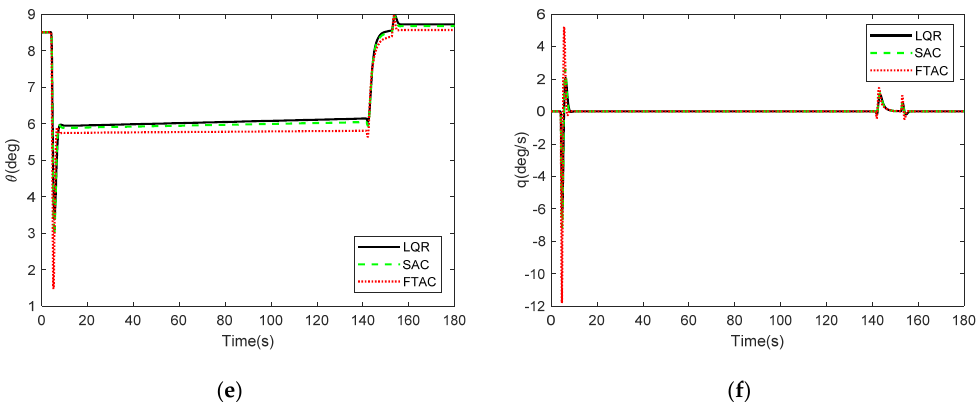
Figure 8. Scenario 1–No wind disturbance, ( a ) Altitude response ( b ) Altitude error. ( c ) Velocity response ( d ) Descent rate response. ( e ) Pitch angle response. ( f ) Pitch rate response.